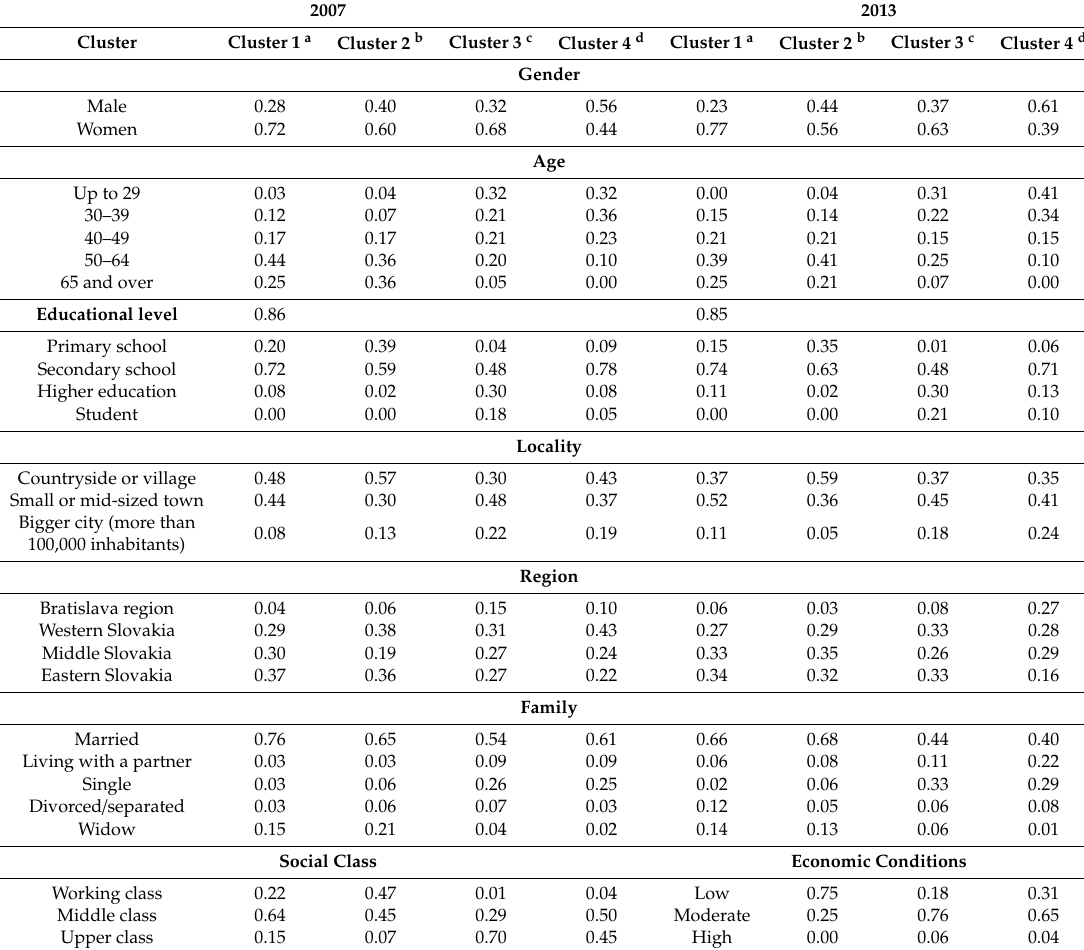
Table 4. Profile of Clusters Based on the Socioeconomic Characteristics of Individuals (Conditional